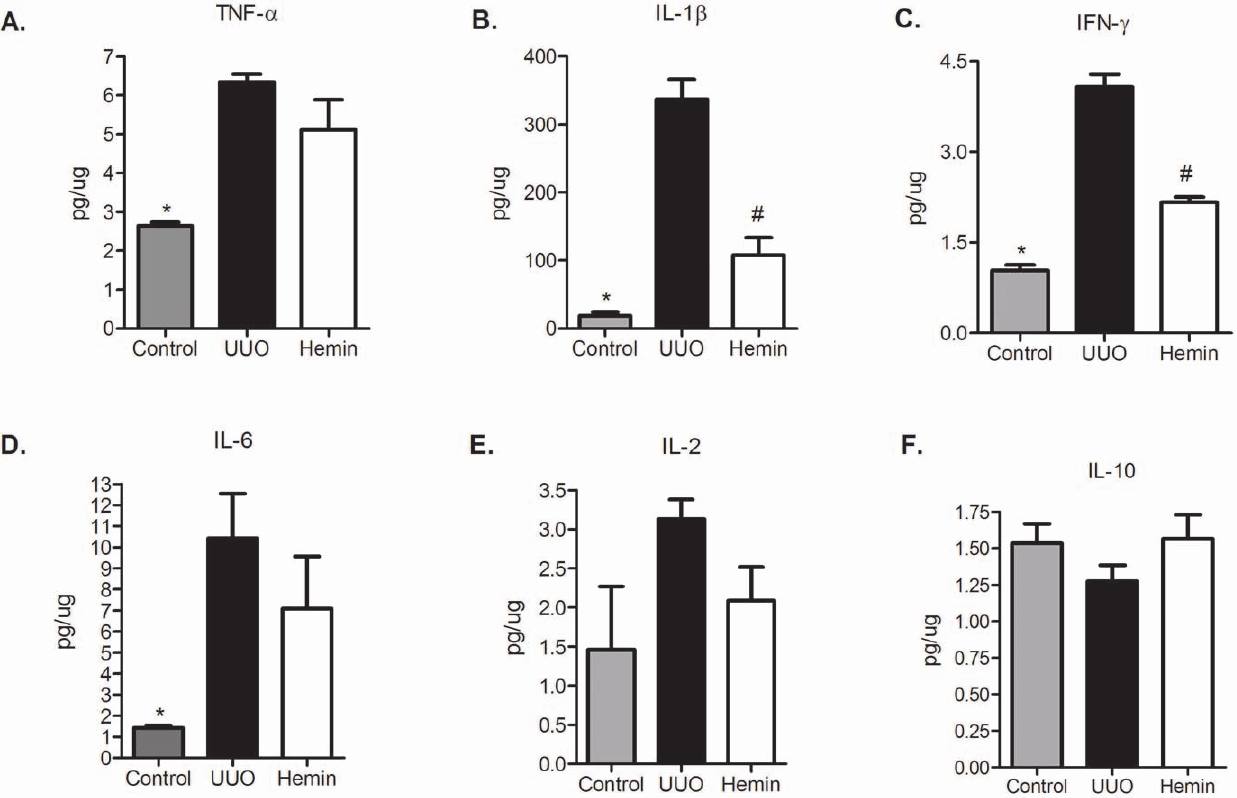
Figure 11. Late treatment with Hemin still maintains a dimished kidney protein expression (average ± s.e.m.) of TNF- a (panel A), IL- 1 b (panel B), IFN- c (panel C), IL-6 (panel D) and IL-2 (panel E) and increased protein expression of IL-10 (panel F). * p , 0,05 vs UUO and Hemin; # p , 0,05 vs UUO.